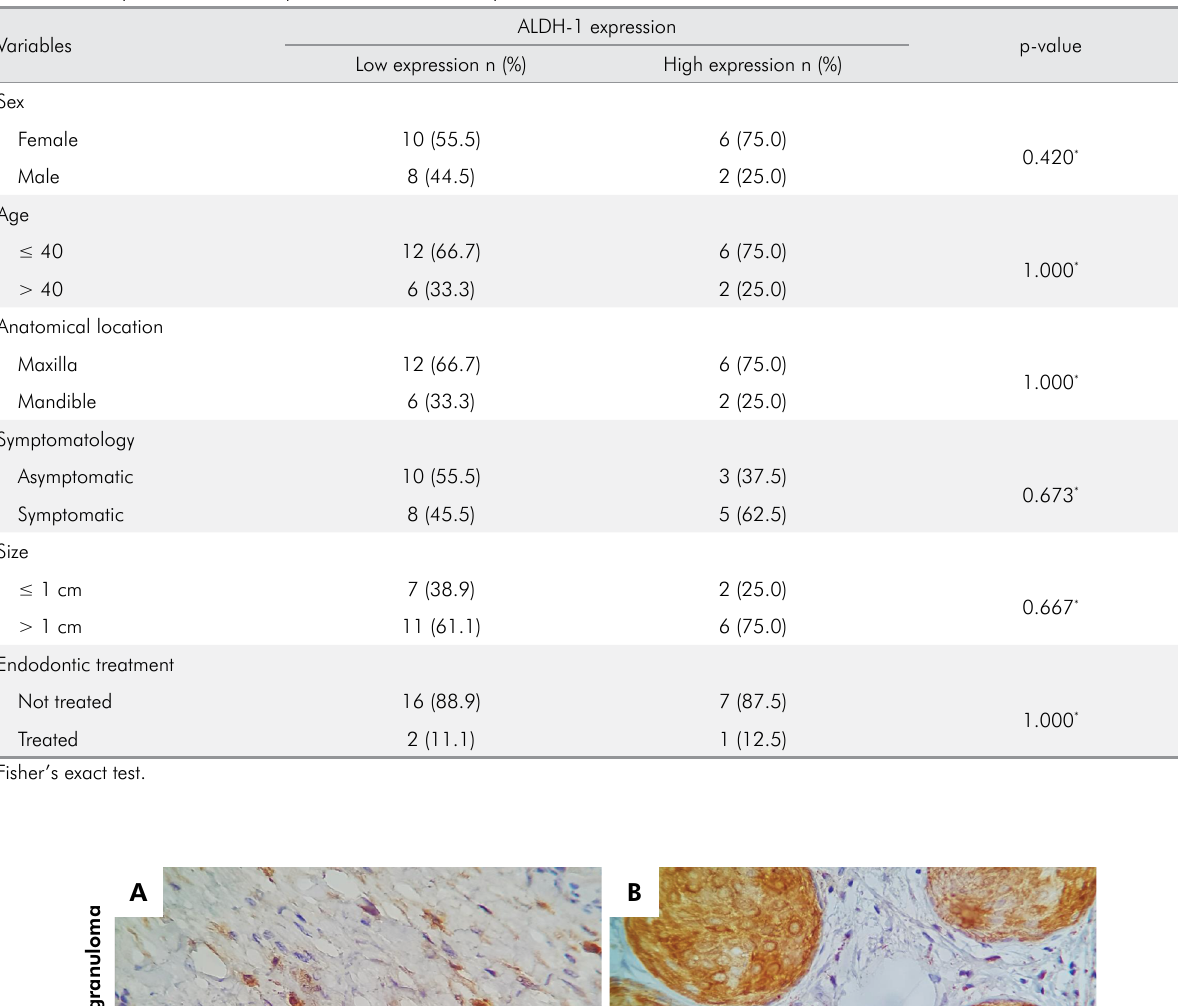
Table 4. Analysis of ALDH-1 expression in radicular